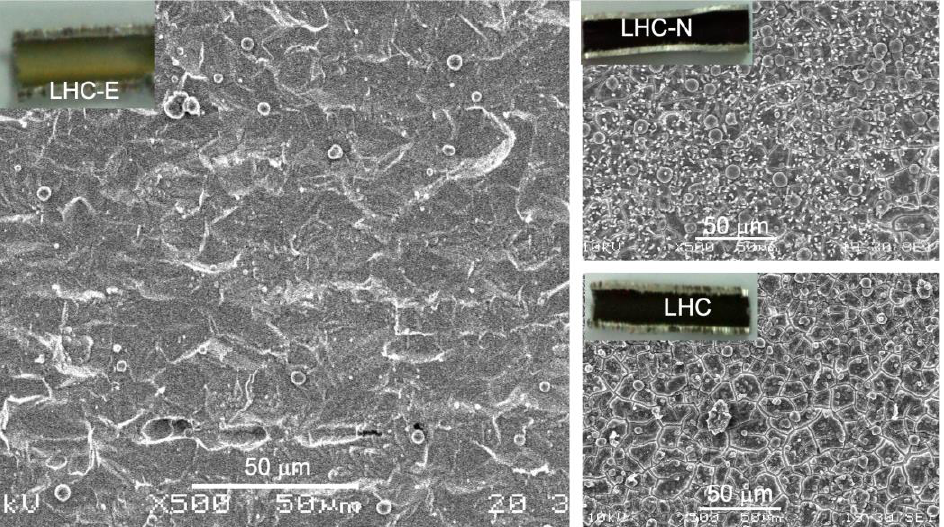
Figure 9. Examination of coking extents occurring inside the three sample tubes that were prepared using a 50 rpm pumping rate to circulate the etchants after a single cycle. Before performing a microscopic check, the sealed lubricant was subjected to a single heating cycle (56 h) at 300 °C. (Insets: photos of the scissored tubes.)